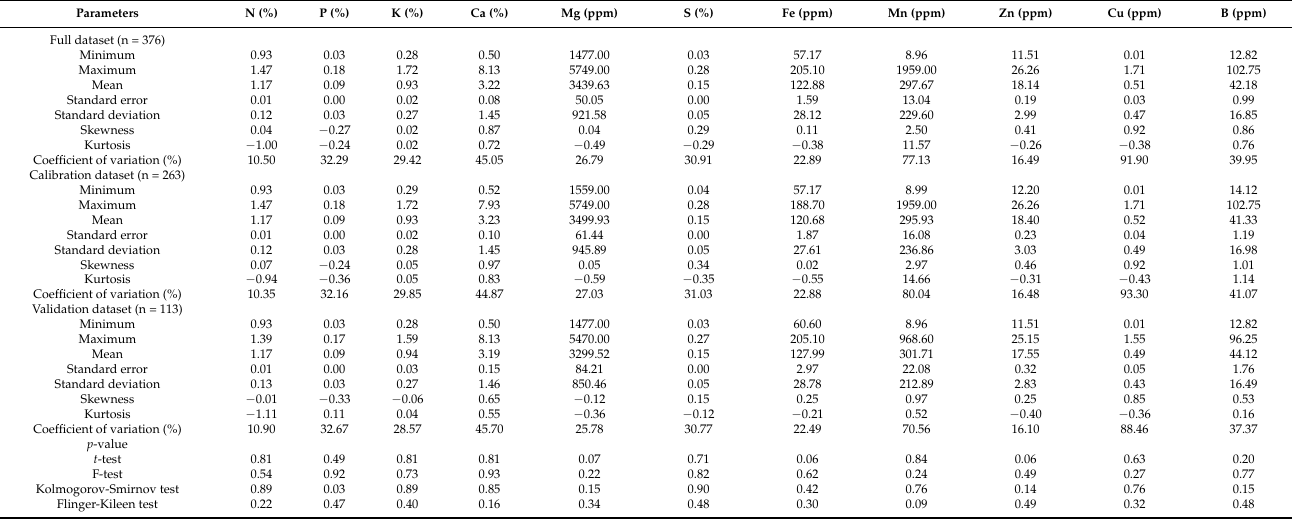
Table 1. Summary statistics of the mango leaf nutrient content for full (n = 376), calibration (n = 263) and validation (n = 113) dataset.